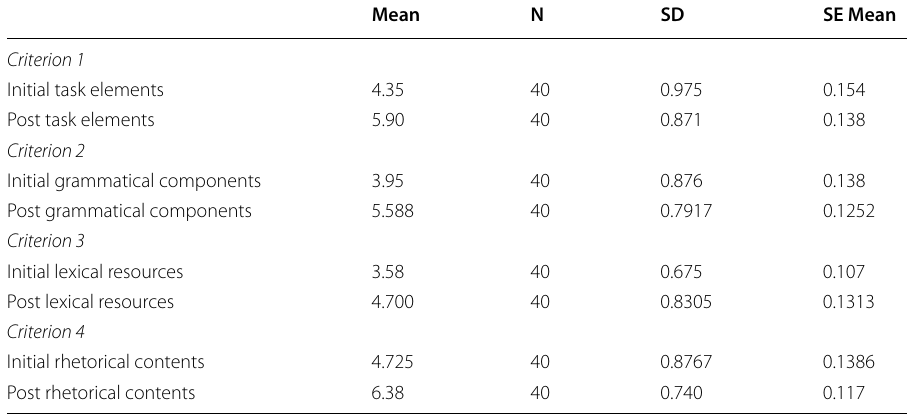
Table 2 Means and standard deviations of scores for each criterion before and after the